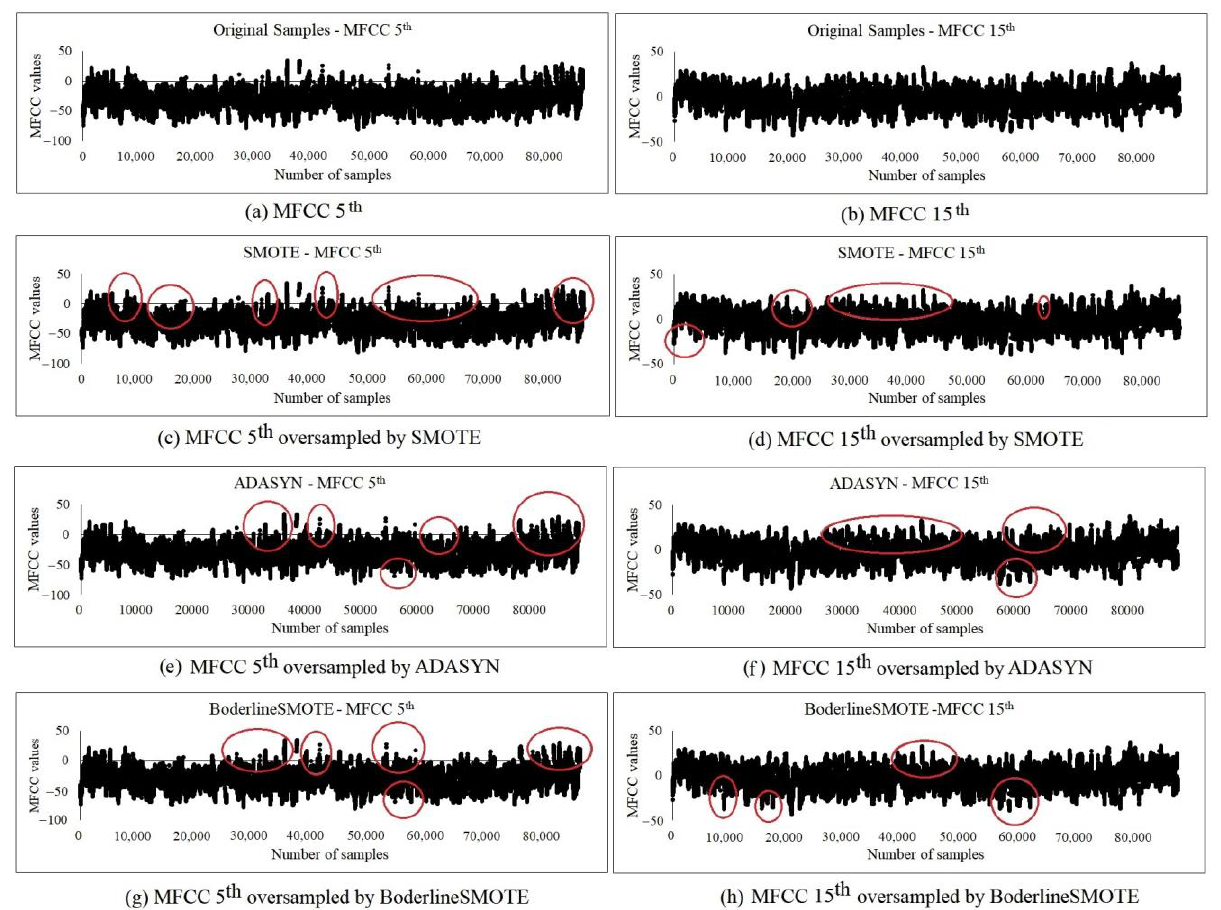
Figure 5. MFCCs of the fifth and fifteenth normal voice samples oversampled using various over- sampling methods.